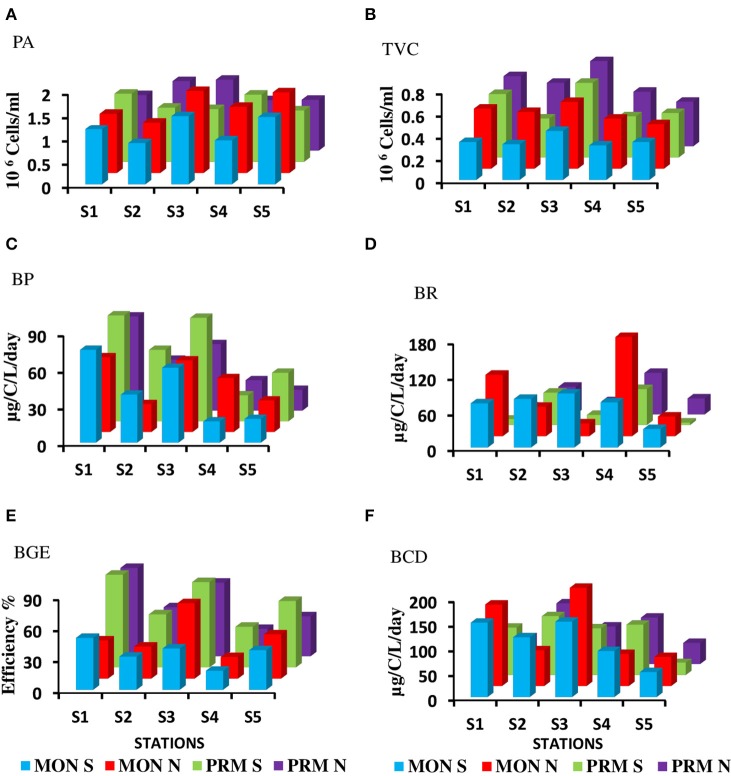
Mean distribution of bacterial parameters during monsoon (MON) and Pre-monsoon (PRM) (A) Prokaryotic abundance in 106 cells/ml (PA) (B) Viable bacterial abundance in 106 cells/ml (TVC) (C) Bacterial production in μg/C/L/day) (BP) (D) Bacterial respiration in μg/c/l/day) (BR), (E) Bacterial growth efficiency % (BGE) (F) Bacterial carbon demand in (μg/c/l/day) (BCD). Spring and neap tide observations are denoted as S and N, respectively.